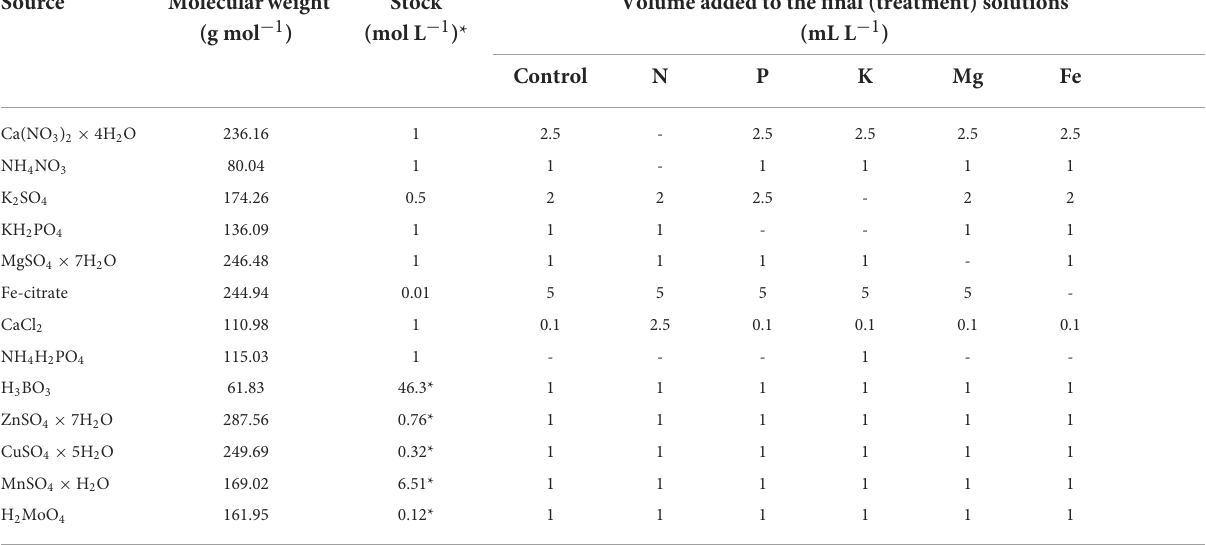
TABLE 1 Chemicals used for the preparation of the stock solution and volume of the stock solutions used to produce the treatment solutions. Source Molecularweight Stock Volume added to the final (treatment) solutions (g mol − 1 ) (mol L − 1 ) *